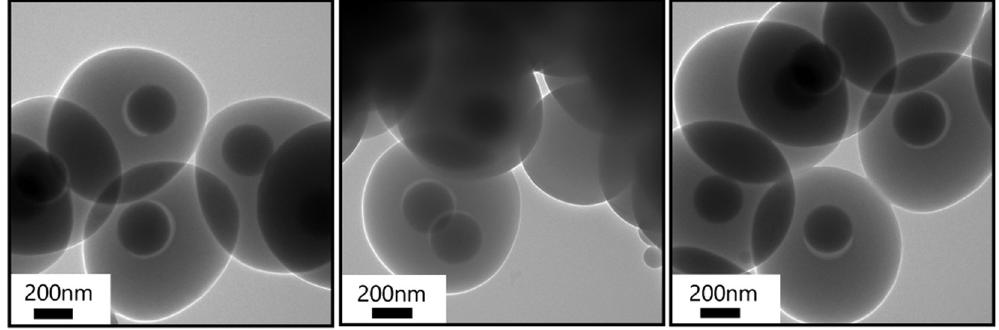
Figure 4: TEM images of the PMS/SiO 2 – MAPTMS core – shell particles. The polymer shell was cross - linked with